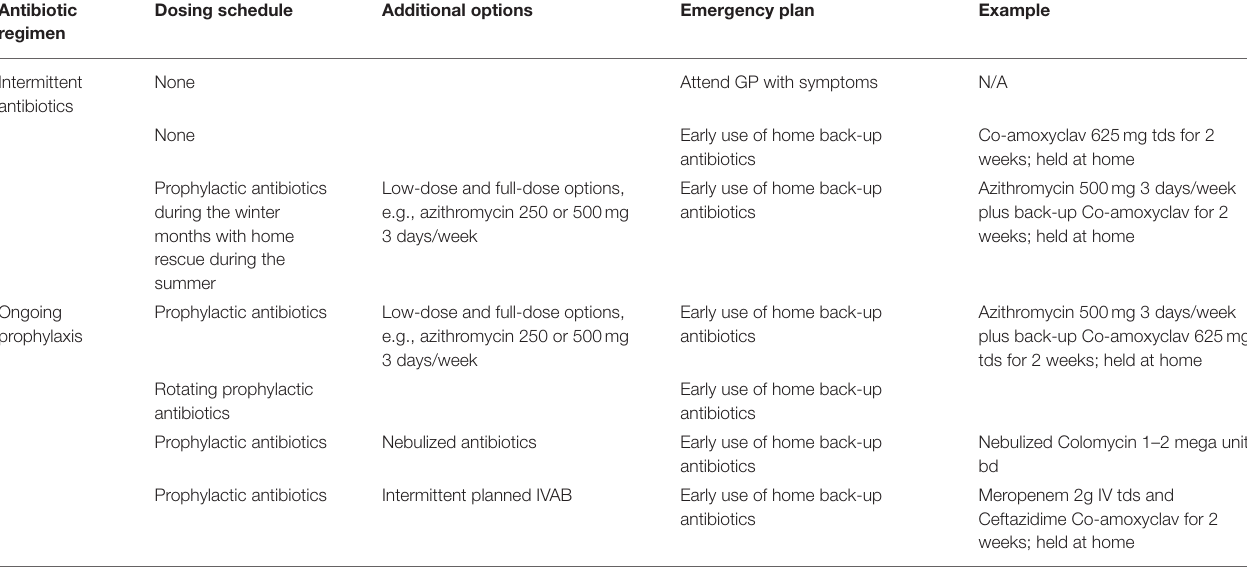
TABLE 3 | Graded antibiotic regimens*.